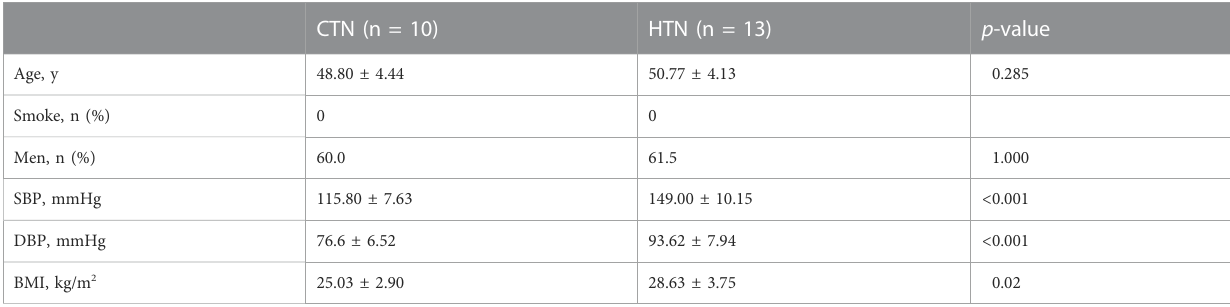
TABLE 2 Basic characteristics of normotensive controls and hypertensive patients for fl ow cytometry.